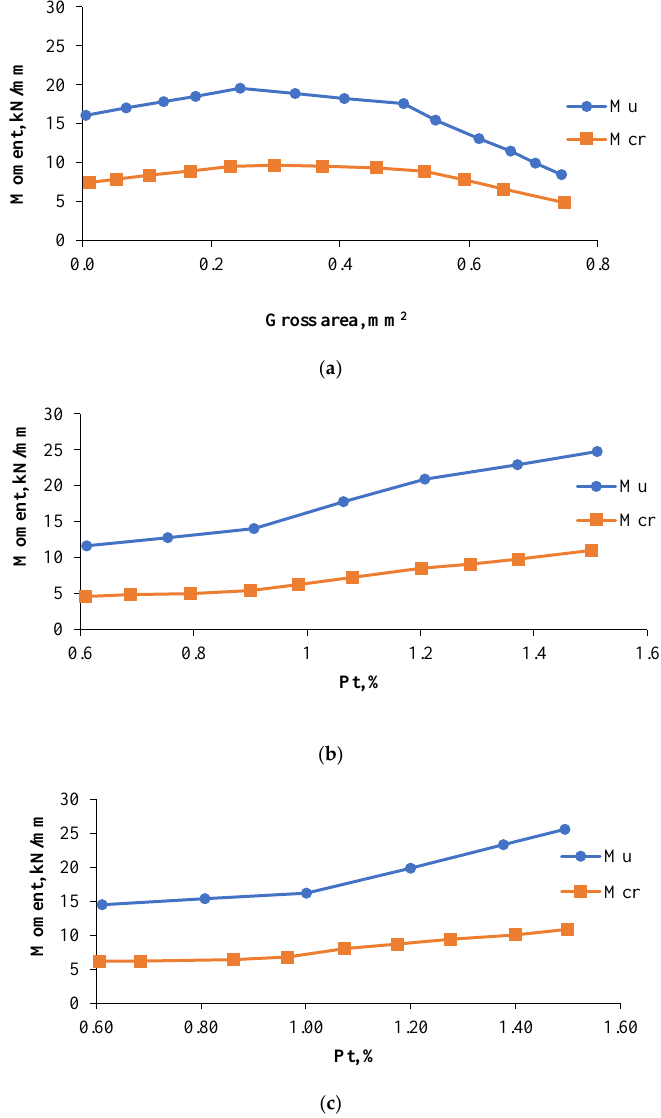
Figure 7. Cracking and the ultimate moment of resistance of sandwich beams ( a ) effect of inner core; ( b ) effect of reinforcement ratio; ( c ) effect of wire mesh.